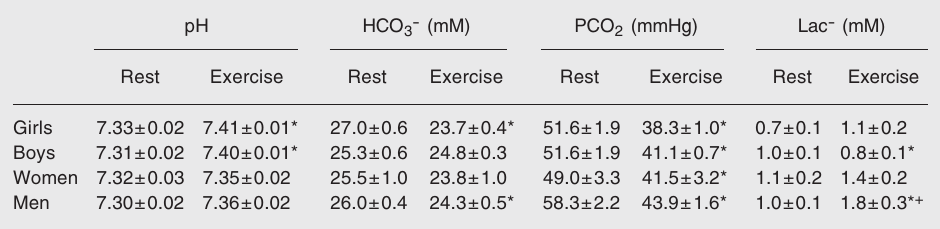
Data are reported as mean ± SEM.